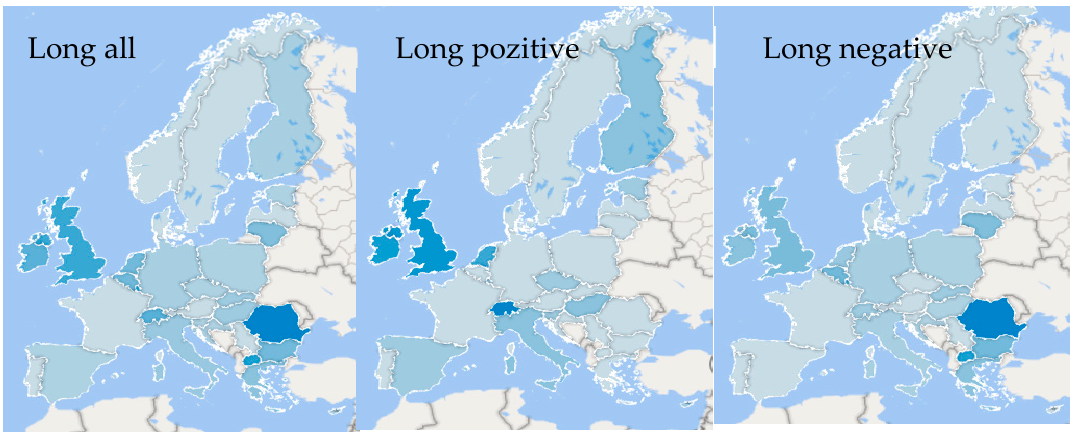
Figure 13. Number of precedence by country, long precedencies, group Eco by effect. Geospatial distribution.